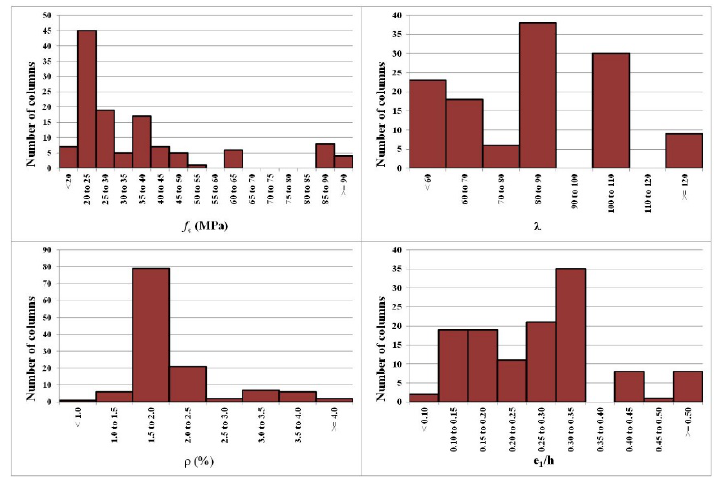
Figure 12. Distribution of database